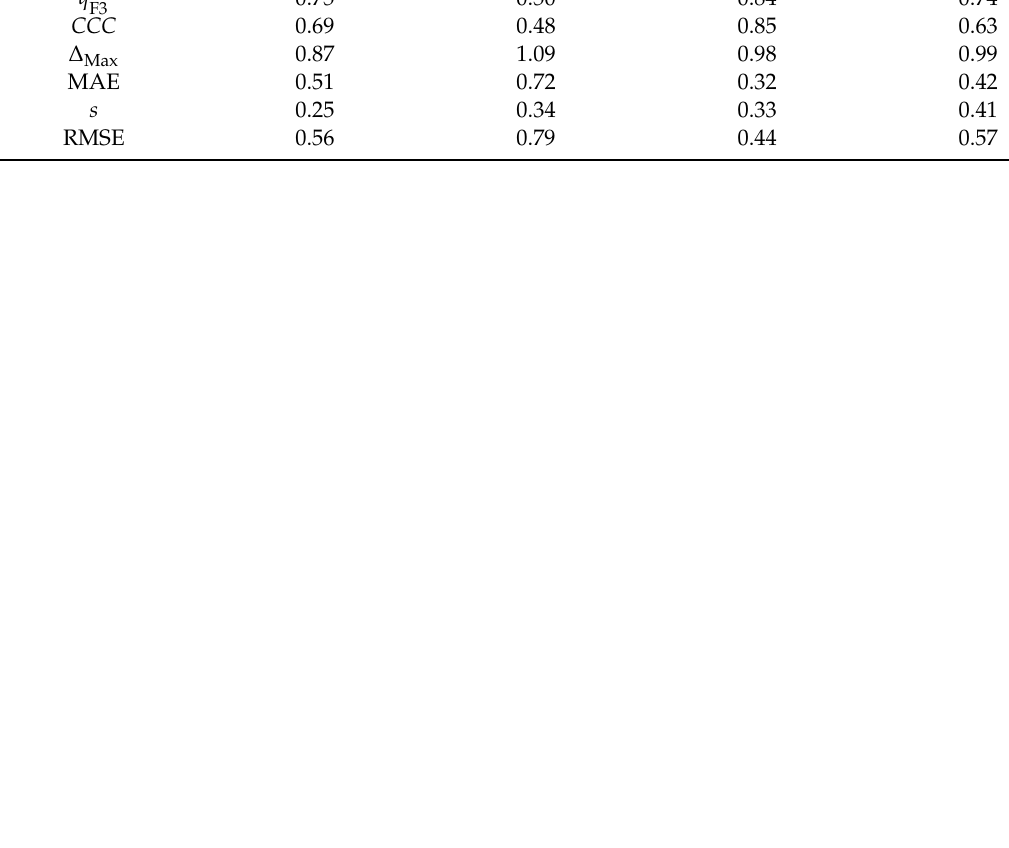
Table 4. Statistic evaluations, correlation coe ffi cients q 2 , q 2